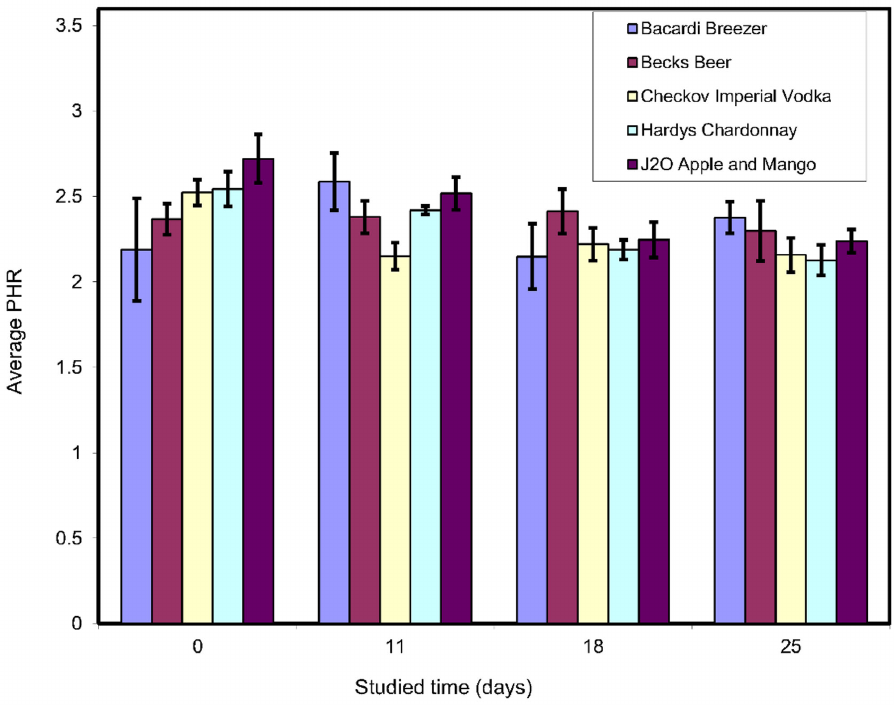
Figure 2. Peak height ratio (PHR) of flunitrazepam: diazepam -d 5 (n=3).